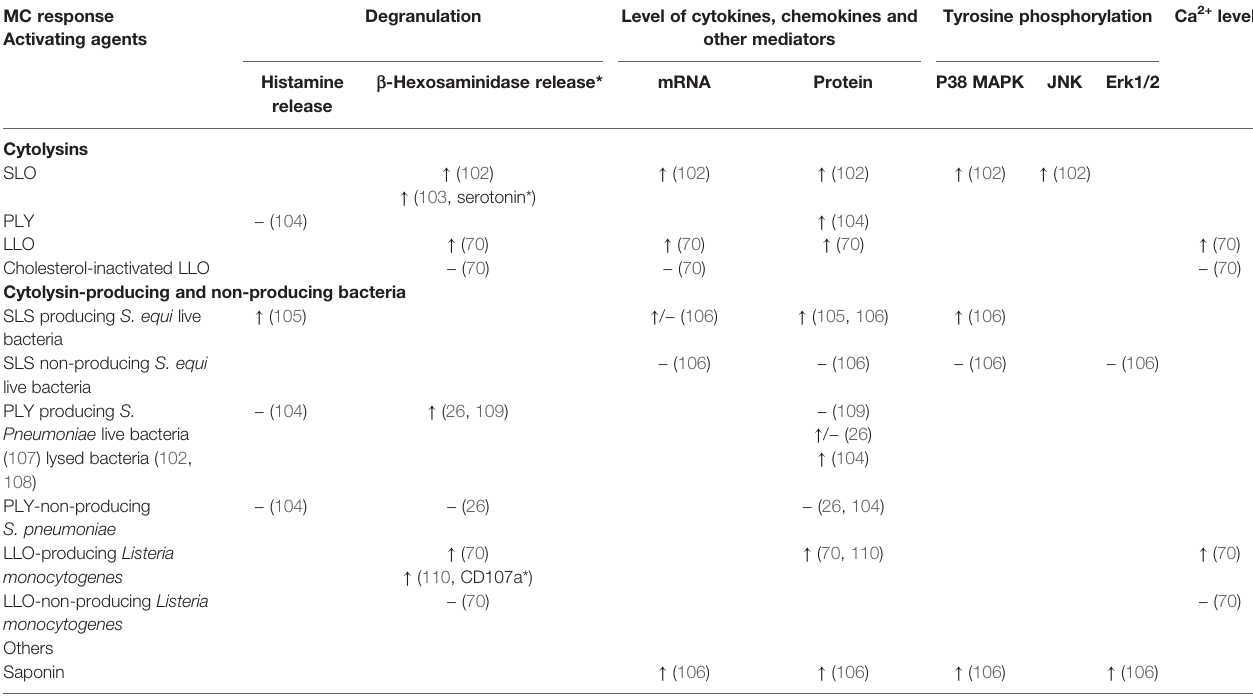
TABLE 2 | Effect of various cytolysins at sublytic concentrations on mast cell degranulation, production of cytokines, chemokines, and other mediators, tyrosine phosphorylation of signaling molecules, and Ca 2+